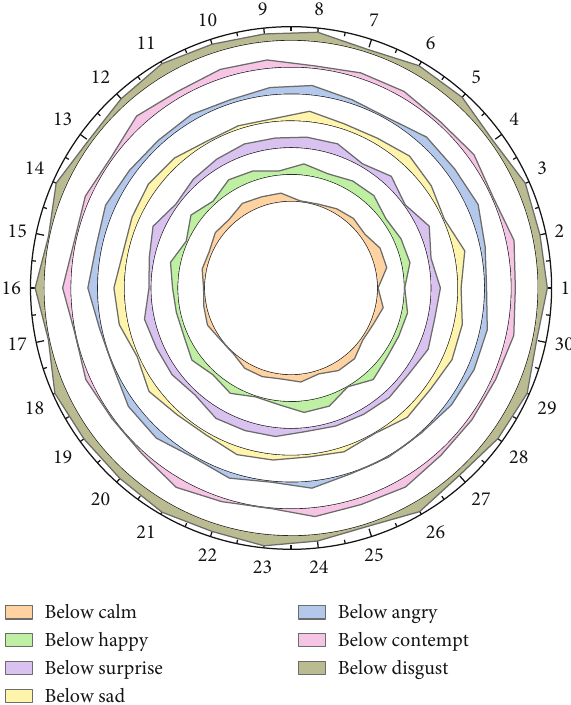
Figure 6: Normalization results and clustering categories for young children ’ s